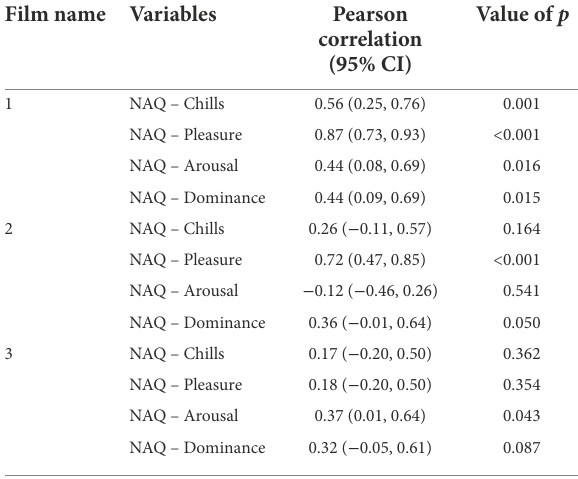
TABLE 3 The association between NAQ score and variables including chills, pleasure, arousal, and